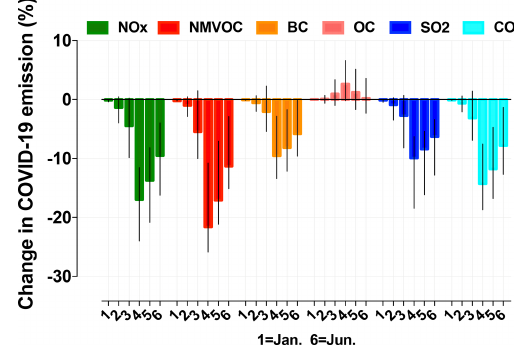
Figure 7. Global percentage change in total emissions (combina- tion of emissions from ground transportation, industry, power, res- idential and shipping) of the main atmospheric compounds from January to June 2020. The vertical lines show the uncertainties as- sociated with the estimated regional